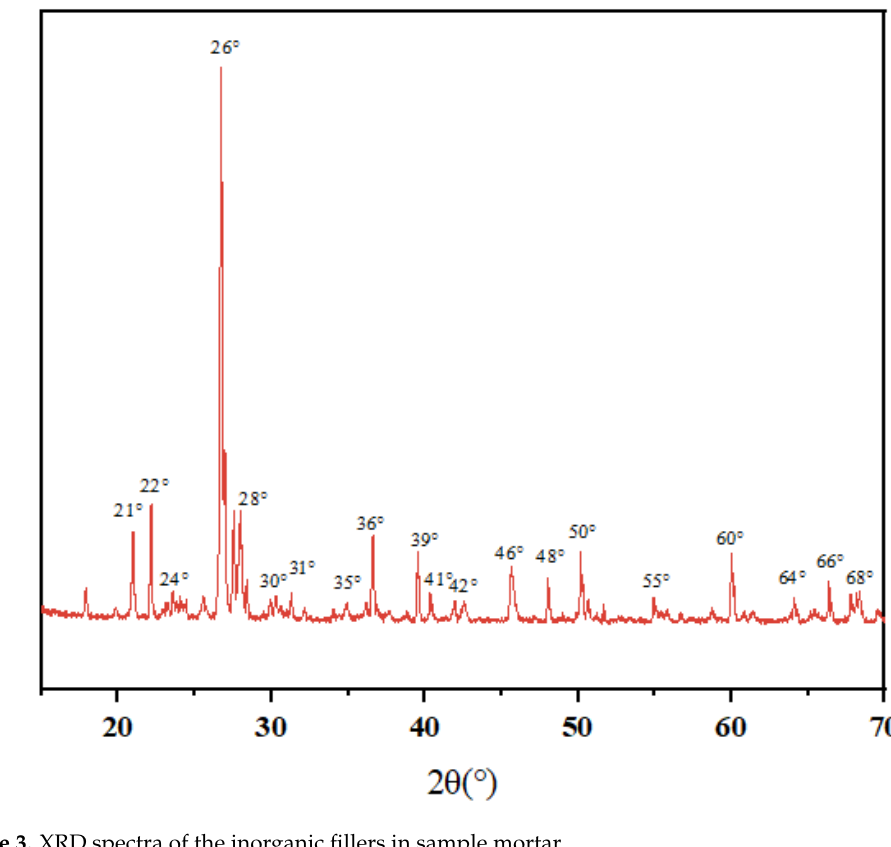
Figure 3. XRD spectra of the inorganic fillers in sample mortar.